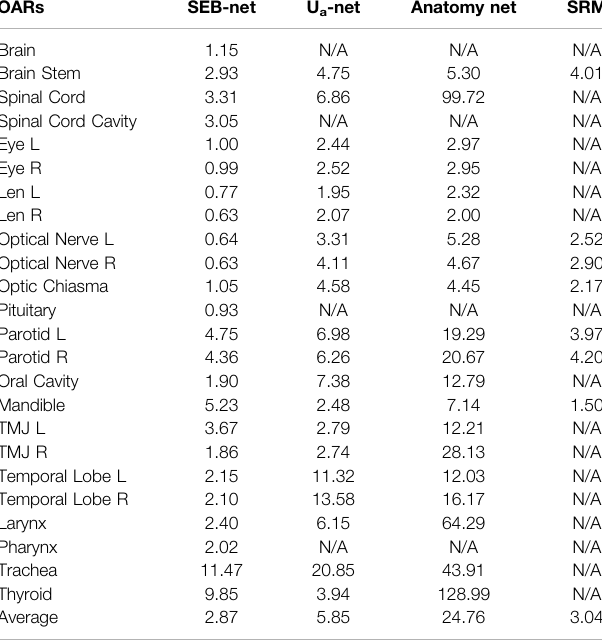
TABLE 4 | Average 95% HD comparison on the test (unit: mm). OARs